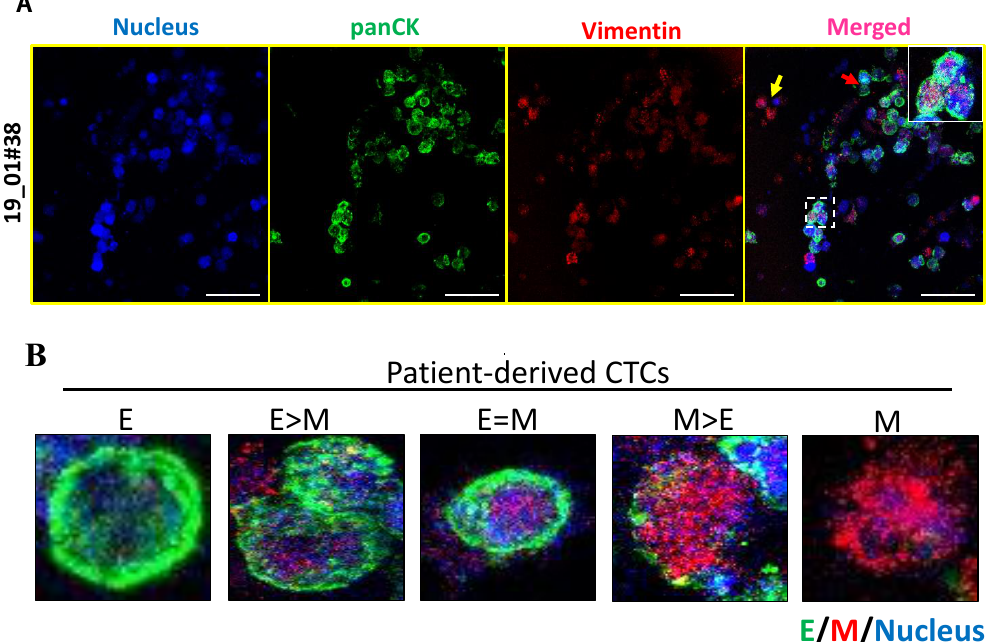
Figure 6. E-M heterogeneity and intermediate phenotypes in breast cancer patient-derived CTCs. ( A ) Co-staining for panCK and vimentin in patient-derived CTCs revealed the presence of marked heterogeneity with respect to E and M marker expression. ( B ) Representative fluorescence images of 5 di ff erent types of CTCs: E (exclusively), E > M, E = M, M > E and M (exclusively). Cells were counterstained for nucleus (Hoechst 33342, blue), E-type markers (green), and M-type markers (red). Imaging was performed using confocal microscope and maximum intensity projections are shown. Scale bar represents 40 µ m ( A ). Images are representative of 2 independent patient